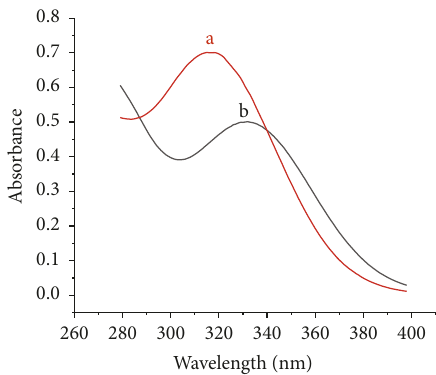
Figure 3: UV spectra of 60 µ M HDPBA in ethanol (a) in the absence of Cd(II) and (b) in the presence of